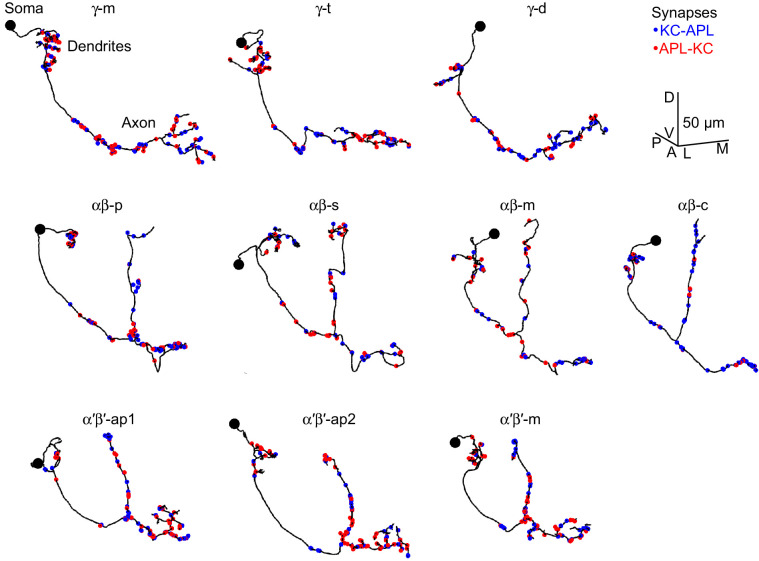
Example Kenyon cells.Line drawings of example Kenyon cells of subtype γ-m (A), γ-t (B), γ-d (C), αβ-p (D), αβ-s (E), αβ-m (F), αβ-c (G), α′β′-ap1 (H), α′β′-ap2 (I), α′β′-m (J) from the hemibrain connectome (v1.1). γ-d and αβ-d Kenyon cells receive primarily visual input from the ventral and dorsal accessory calyces, respectively (Li et al., 2020; Vogt et al., 2016). The node with the biggest radius >1.25 µm was annotated as the soma (black circle); not all skeletons had a clear soma. Red circles, APL-KC synapses; blue circles, KC-APL synapses. Scale bar, 50 µm, D, dorsal, V, ventral, A, anterior, P, posterior, L, lateral, M, medial. bodyId numbers: (A) 5812981148, (B) 630731599, (C) 1004514714, (D) 456462835, (E) 5813055914, (F) 941111195, (G) 922677121, (H) 518864924, (I) 674393414, (J) 5812981553.